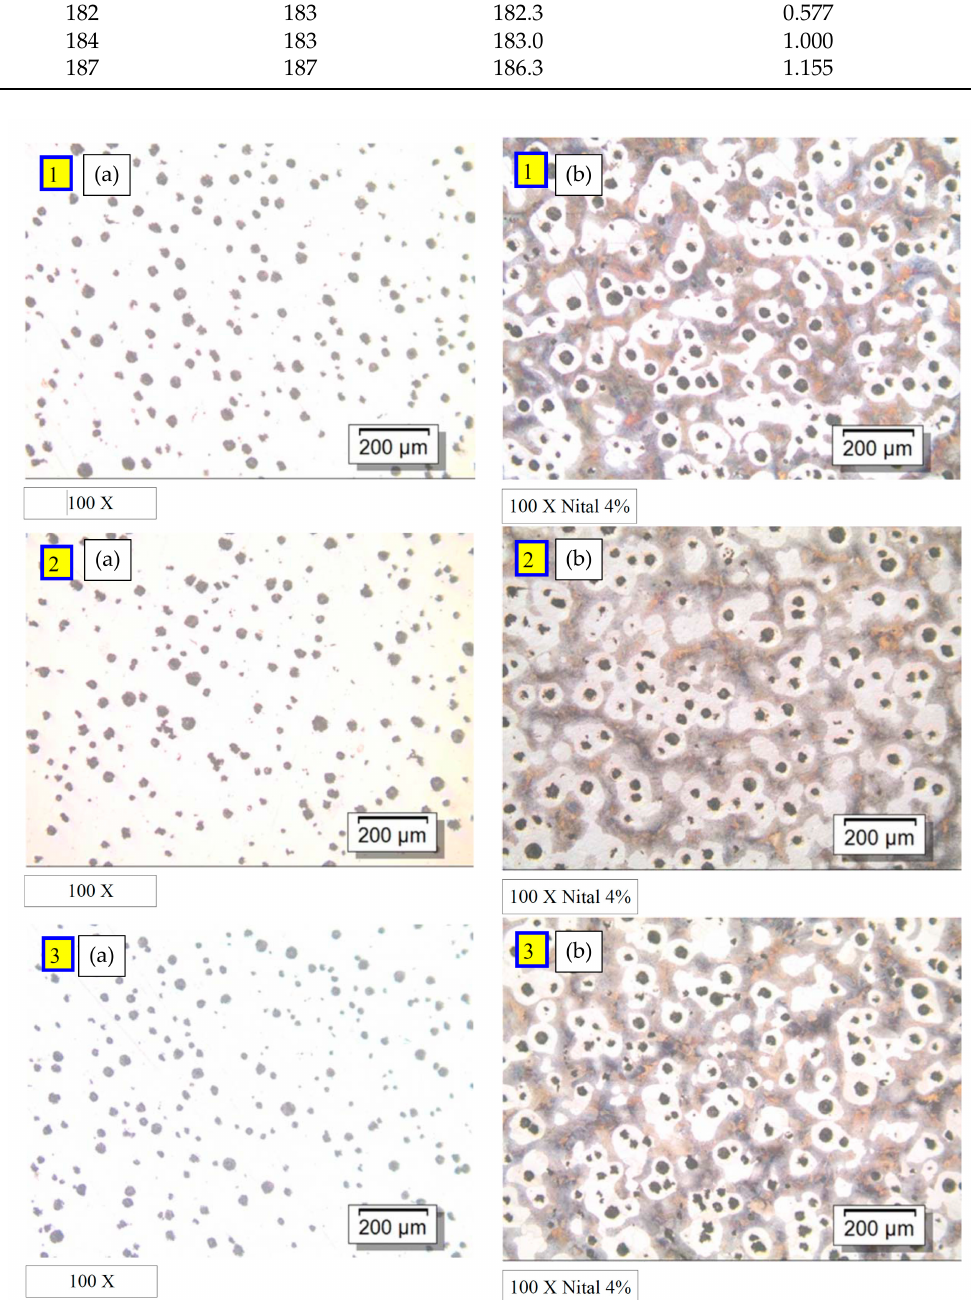
Figure 3. Microstructures ( 1a ), ( 2a ), ( 3a ) before and ( 1b ), ( 2b ), ( 3b ) after Nital 4% etching as